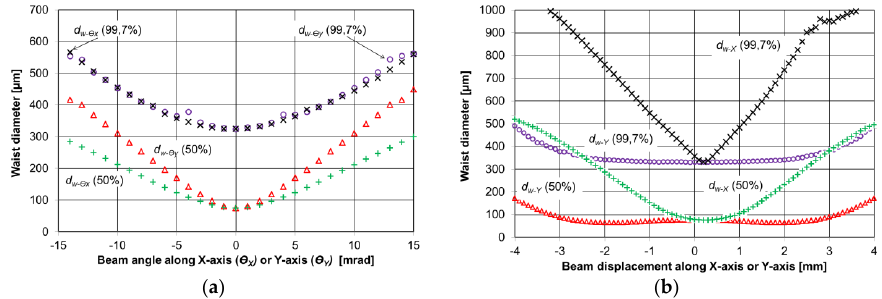
Figure 5. ( a ) Results of simulation of the QCL 4 mm beam waist diameter ( d w ) inside the cavity versus the QCL beam angle; and ( b ) the beam displacement.